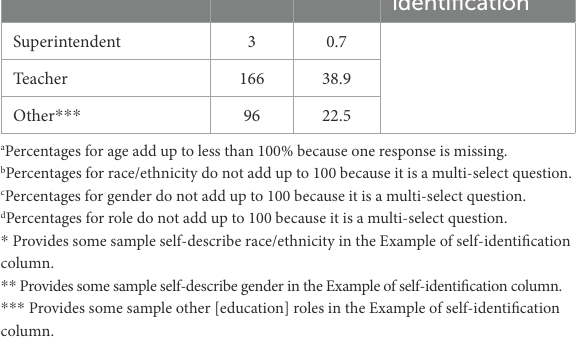
TABLE 2 Social and emotional learning curriculums used. Demographic